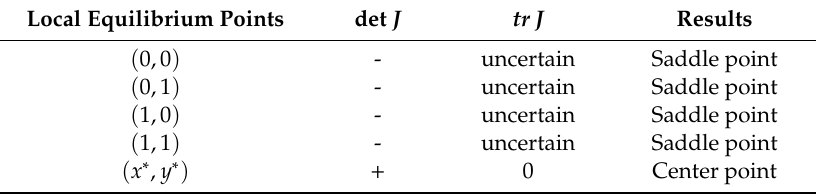
Table 4. Stability analysis equilibrium points when α > ε > βλ > 0 or 0 < α < ε < βλ . Local Equilibrium Points det J tr J Results ( 0,0 ) - uncertain Saddle point ( 0,1 ) - uncertain Saddle point ( 1,0 ) - uncertain Saddle point ( 1,1 ) - uncertain Saddle point 0 Center